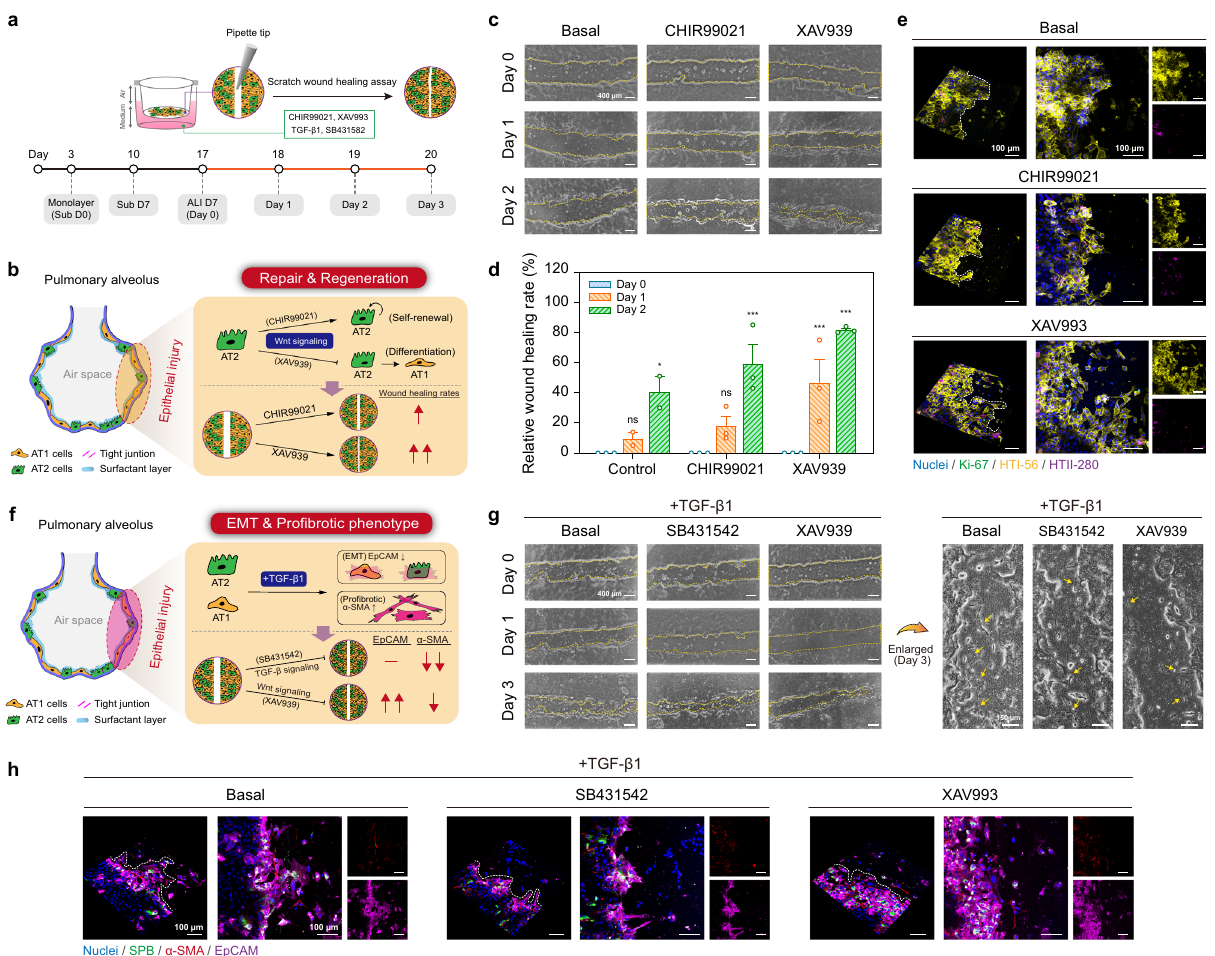
Fig. 5 HPAEpiC repair response in damaged human alveolar model. a Timeline fl owchart showing HPAEpiC culture steps during wound healing process under ALI culturing condition. The HPAEpiCs were maintained under Sub-culturing for 7 days and ALI culturing for 7 days to create a damaged human alveolar model; then, a 200- μ l pipette tip was used to scratch the wound area. b Schematic of experiment on HPAEpiC repair and regeneration after injury. Both Wnt signaling activation (CHIR99021) and inhibition (XAV939) improved wound healing ef fi ciency. c Bright- fi eld microscope images showing changes in wound healing process after treatment with CHIR99021 and XAV939. The dotted line represents the wound healing boundary. d Quanti fi cation of wound healing rate during 2 days post-scratching. The wound healing ability was in the order of XAV939 > CHIR99021 > control. e After 2 days of treatment, the HPAEpiCs were stained with Ki-67 (green), HTI-56 (yellow), and HTII-280 (purple) antibodies. The white dotted line represents the wound healing boundary, and it shows a certain number of HTI-56 + (AT1 cells) and HTII-280 + cells (AT2 cells), as well as a few Ki-67 + cells (proliferating cells) around the wound healing area. f Schematic of experiment on HPAEpiC repair and regeneration during TGF- β 1 activated wound healing process. SB431542 (a TGF- β 1 inhibitor) and XAV939 both reduced fi broblast activation. Importantly, XAV939 maintained the epithelial cell phenotype. g Bright- fi eld microscope images showing changes in TGF- β 1 activated wound healing process after treatment with SB431542 and XAV939. The dotted line represents the wound healing boundary, and the arrowhead indicates elongated spindle-shaped cells (mesenchymal-like cells). h After 3 days of treatment, the HPAEpiCs were stained with SPB (green), α -SMA (red), and EpCAM (purple) antibodies. The dotted line represents the wound healing boundary and shows a certain number of α -SMA + cells (activated fi broblasts) around the wound healing area. In addition, XAV939 was observed to have more EpCAM expression. Data and error bars represent mean ± SEM from three separate experiments. Two-way ANOVA test ( d ). * p < 0.05; *** p < 0.001; ns non- signi fi feasibility of large-scale alveolar modeling (Fig. 3). We demon- strated that the Sub condition promotes AT2-cell proliferation in the alveolar model, and we revealed that the alveolar models obtained under precultured Sub D7 and D14 conditions most closely resemble human alveoli. These fi ndings provide important insights that will aid in the establishment of large-scale alveolar models.